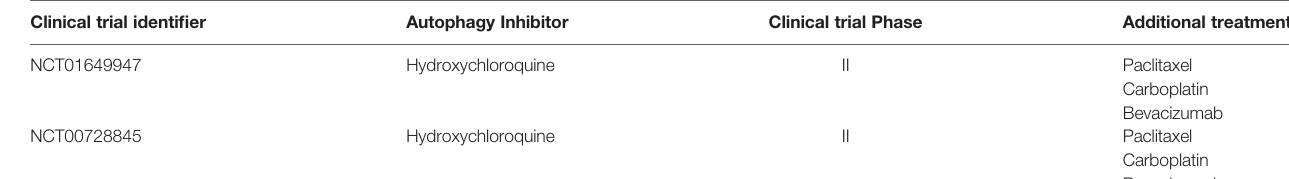
TABLE 2 | The ongoing clinical trials using therapy targeting autophagy in